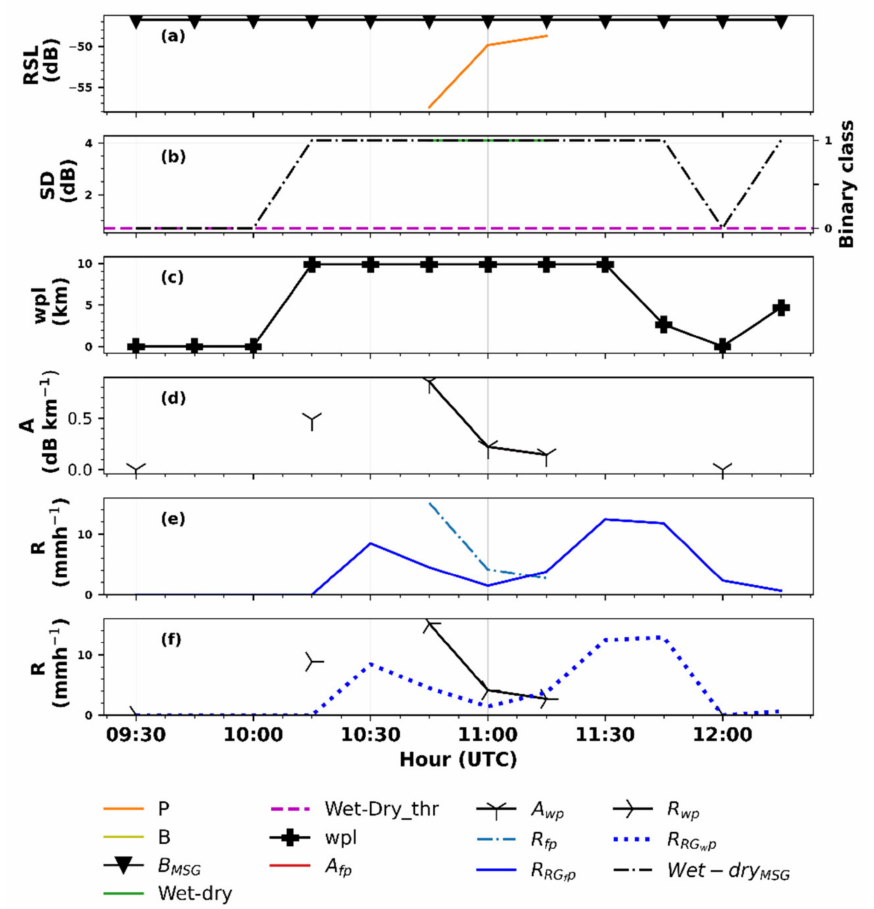
Figure 6. ( a – f ) As in Figure 3 but for 15 min interval rain events of 3 May